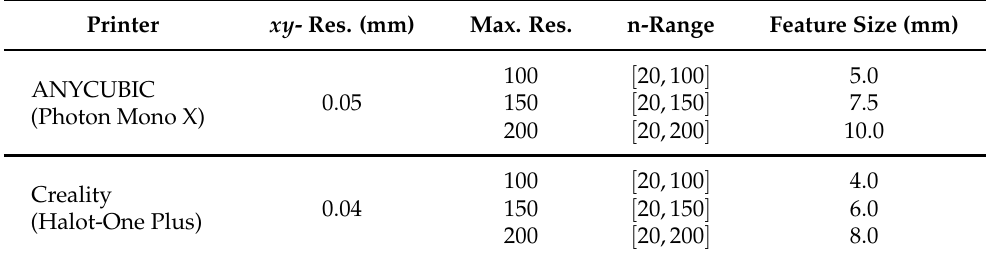
Table 2. Minimum microstructure feature size based on the printer